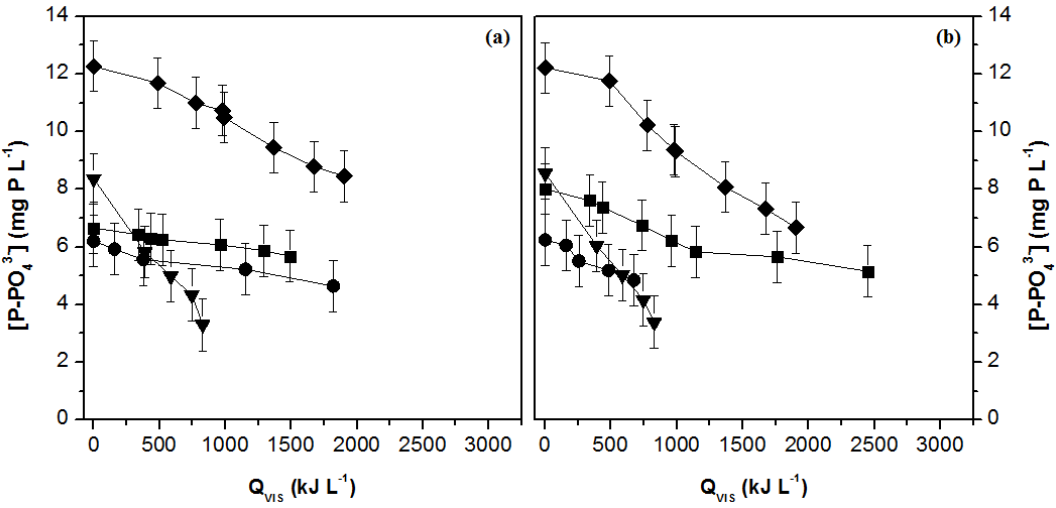
Figure 7. Variation of phosphorus concentration (P-PO 43− ) as a function of the accumulated visible energy ( Q VIS ) in PBR 1 ( a ) and PBR 2 ( b ) for all assays: I— (cid:4) ; II— • ; III— (cid:72) ; IV— (cid:7) . Error bars correspond to the standard deviation of the mean determined for duplicates from two independent experiments.